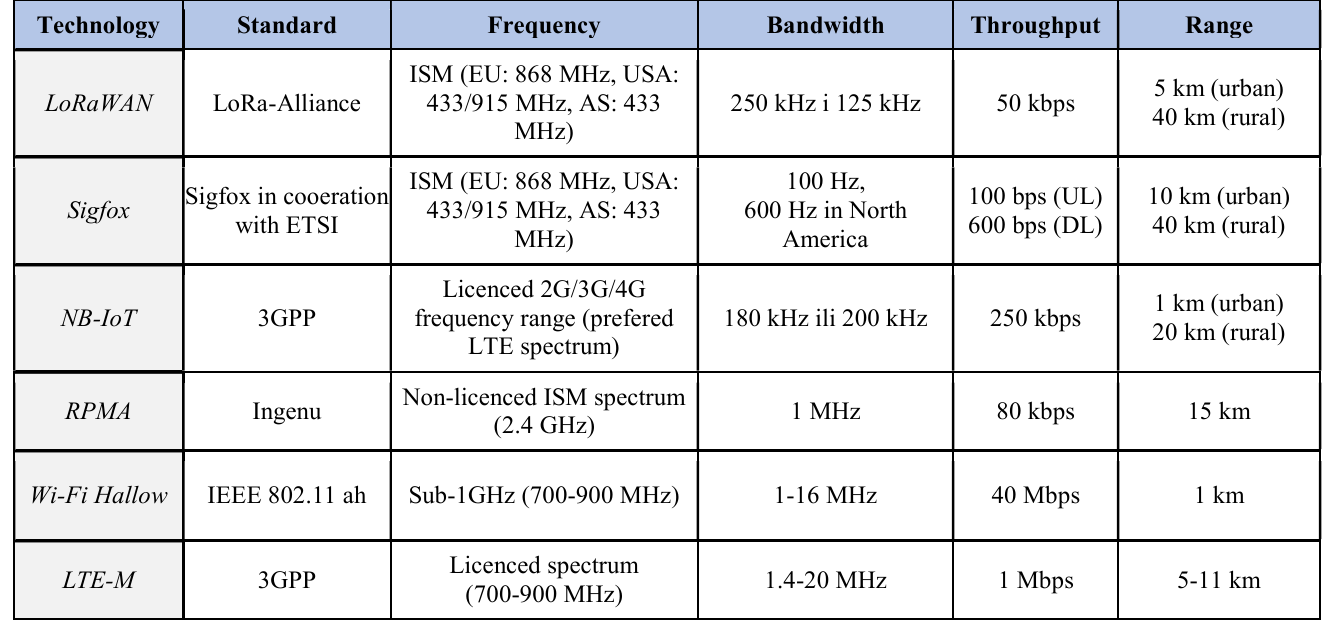
Table 6. An overview of LPWAN